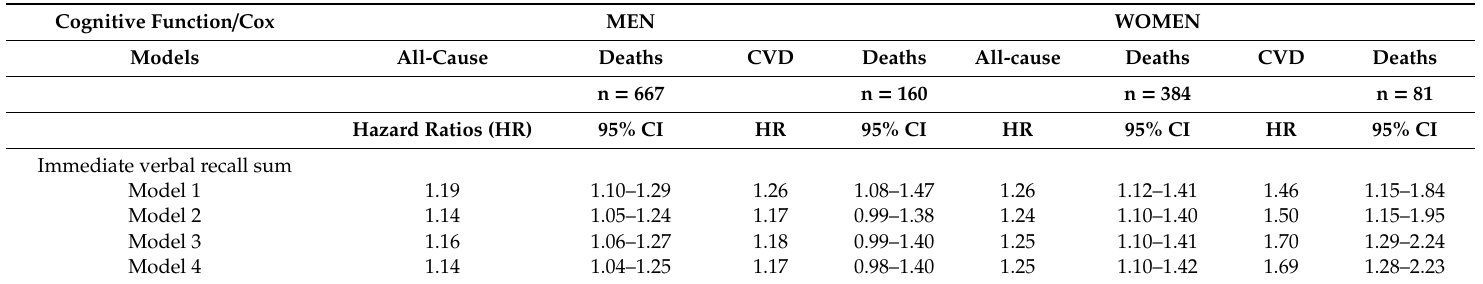
Table 2. Risk of all-cause and cardiovascular mortality* for a decrease in scores of cognitive functions a in men and women, Kaunas Health Alcohol Psychosocial Factors in Eastern Europe (HAPIEE) study,